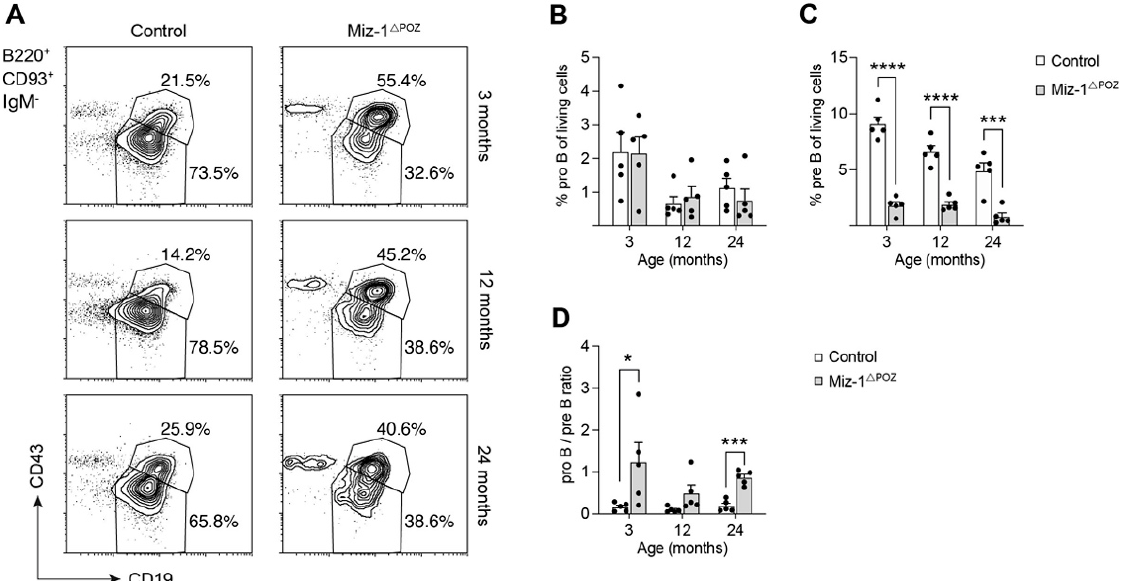
Figure 3. Miz-1 is important for the transition of pro- to pre-B cells during development. ( A ) Flow cytometric analysis of bone marrow cells from control and Miz-1 Δ POZ mice at different ages. Percent- ages in plots are given for the respective gates and are quantified as percentage of B220 + CD93 − IgM − cells. ( B ) Frequency of pro-B cells (B220 + CD19 + CD93 + CD43 + IgM − ) from the bone marrow. ( C ) Fre- quency of pre-B cells (B220 + CD19 + CD93 + CD43 − IgM − ) from the bone marrow. ( D ) Ratio of pro- to pre-B cells from control and Miz-1 ∆ POZ mice at indicated ages. One point represents one mouse. Data are expressed as mean + SD ( n = 5). Student’s unpaired t -test: * p < 0.05 *** p < 0.001, **** p < 0.0001. For ( A ), plots are representative of at least five independent experiments.